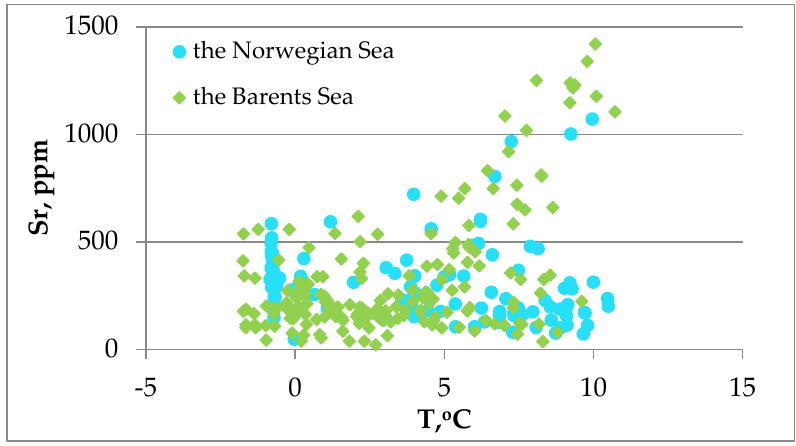
Figure 8. Relationship between temperature and strontium content. The fourth group of elements includes Mn, Ba, Cu, and Pb. These are also accompanied by Cd (in the Norwegian Sea) and U (in the Barents Sea). Grouping of these elements into one cluster is caused by similar patterns of distribution of their contents in SPM. The distribution of Mn can be controlled by redox processes in the water column. In most cases, Mn content has two peaks—in the intermediate layer and in the euphotic layer (Figure 7). Based on the crustal ratio, the fraction of excess manganese exMn was estimated. In general, the exMn fraction decreases in the water column from 90%–99% in the upper horizons to approximately 50% in the BBL. This ambiguous behavior of particulate Mn in the water column indicates that it can be derived from hydrogenic, biogenic, and lithogenic sources. Pelagic Fe and Mn (oxyhydr)oxides that form stable crystalline phases in the SPM of the Barents Sea were revealed and described in [24]. The decisive role of bacterial activity in the formation of these minerals was demonstrated in [77]. Manganese minerals in SPM are parts of manganese recycling and are not involved in sediment or nodule formation because they are dissolved upon settling. The active formation of manganese oxides has been shown to occur in BNL due to the enrichment of benthic water with Mn from pore water [24]. Iron, while also a redox-sensitive element, is uniquely classified as a lithogenic element by the type of vertical distribution in SPM. The highest Mn content in the Barents Sea was observed in the BNL in the area between Svalbard and FJL (Sts. 5555—5561) (Figures 3e and 7f,g). In the same area, Fe-Mn crusts were described on the seafloor based on our investigations during the cruise [61], and Fe-Mn nodules were obtained by [78]. The barium cycle in the ocean is strongly associated with OM regeneration pro- cesses [79]. The vertical distribution of barium is controlled by the processes of barite formation during the decomposition of the organic matter and its further remobilization during the settling of particles [80,81]. Two peaks of barium concentrations in SPM were detected at many stations: (i) In the subsurface horizon and (ii) in the intermediate wa- ter layer (Figure 7). The direct correlation between Mn and Ba may be caused by their participation in biological processes, as well as co-precipitation on Mn-hydroxide films of bacterial